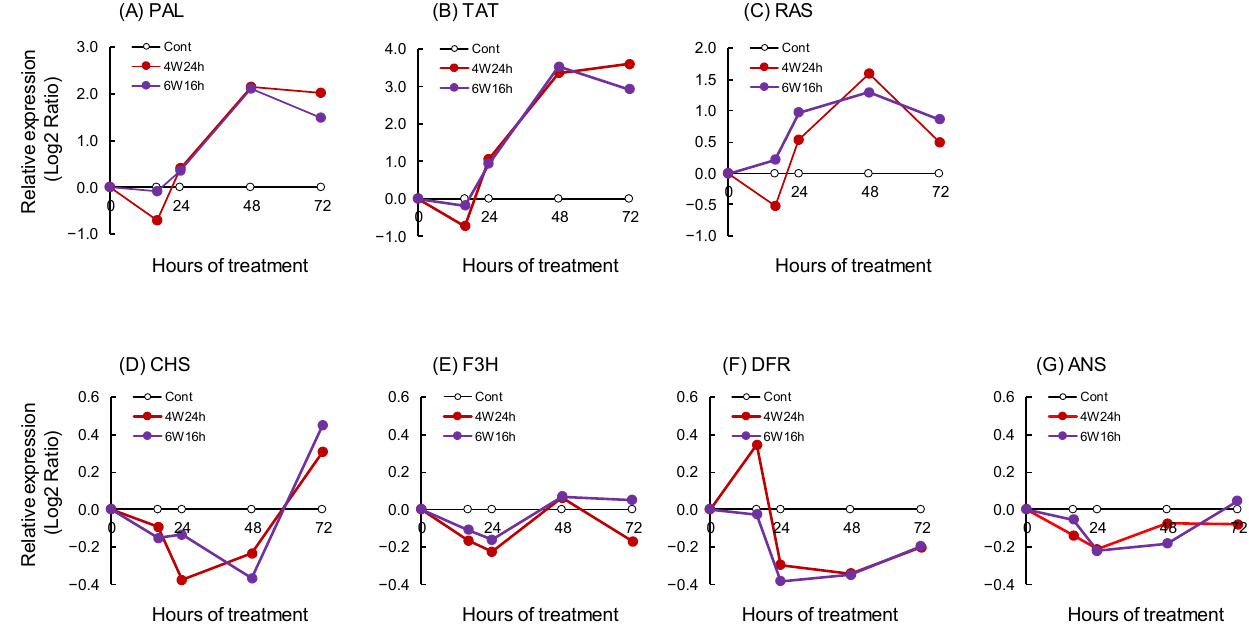
Figure 7. Time courses of PAL ( A ), TAT ( B ), RAS ( C ), CHS ( D ), F3H ( E ), DFR ( F ), and ANS ( G ) mRNA expression in the 4th leaf of red perilla ( n = 4). Red perilla plants with 5 leaves were subjected to the following UV-B irradiation intensities: 0 W m − 2 (control), 4 W m − 2 at continuous irradiation (4 W 24 h), and 6 W m − 2 for 16 h light period (6 W 16 h). Line graphs indicate log 2 fold changes (treatment:control) in gene expression levels.